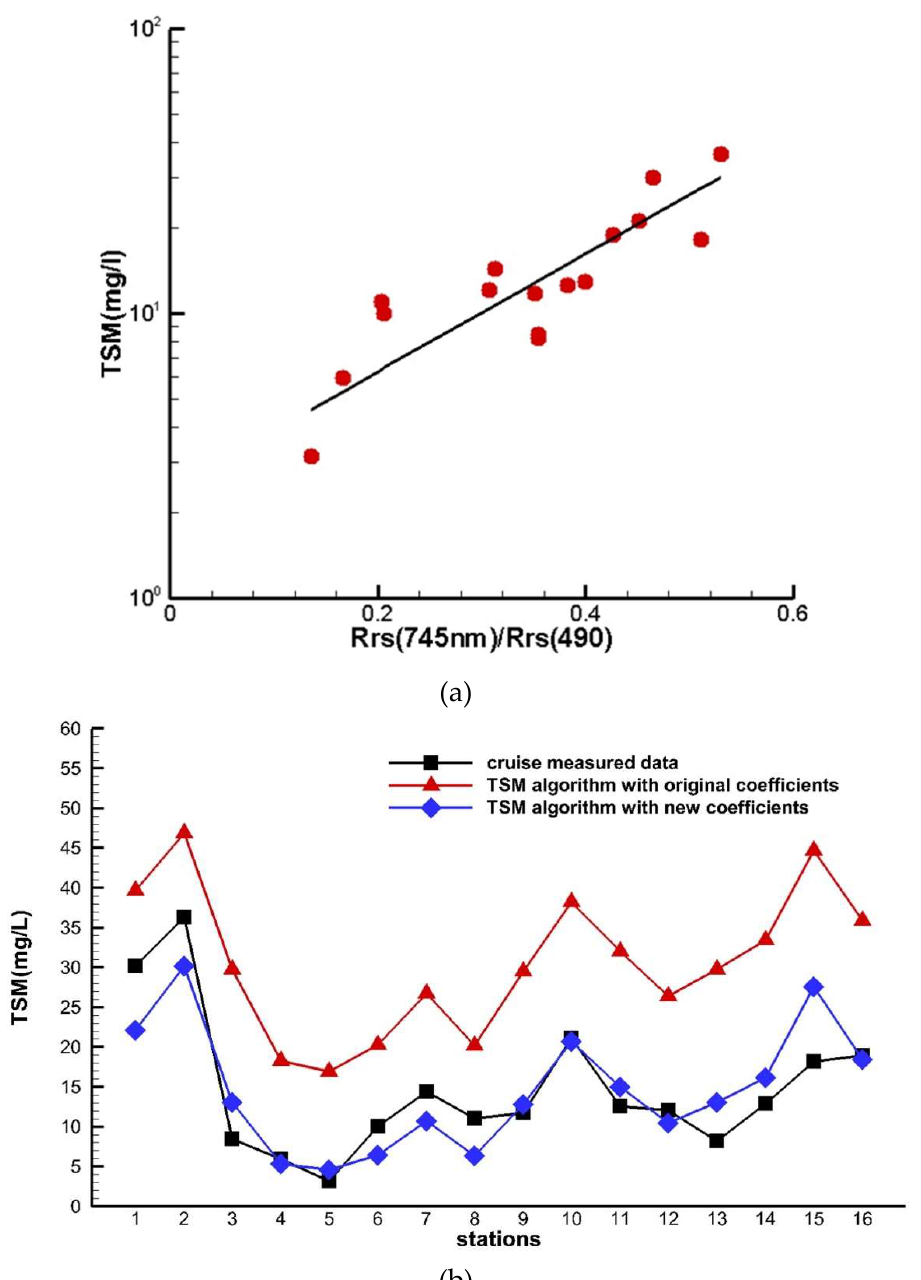
Figure 4. (a) Linear regression of empirical TSM algorithm and (b) comparison of measured data with TSM algorithm. TSM